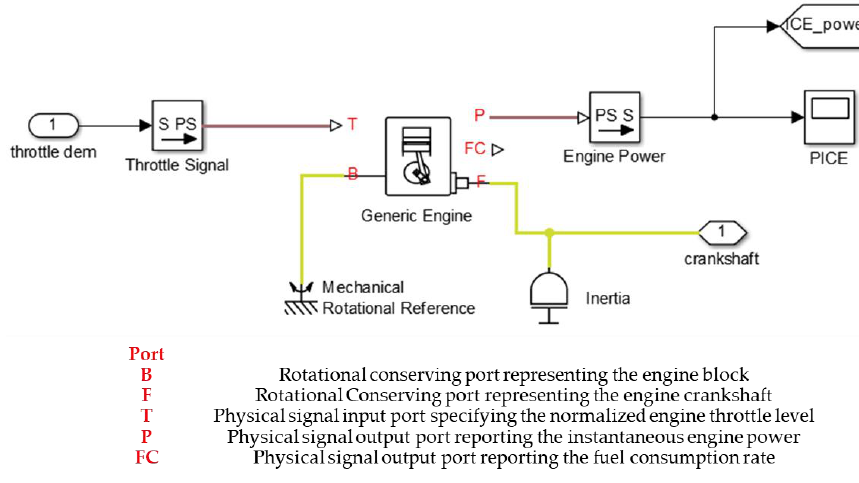
Figure 7. Engine system model.